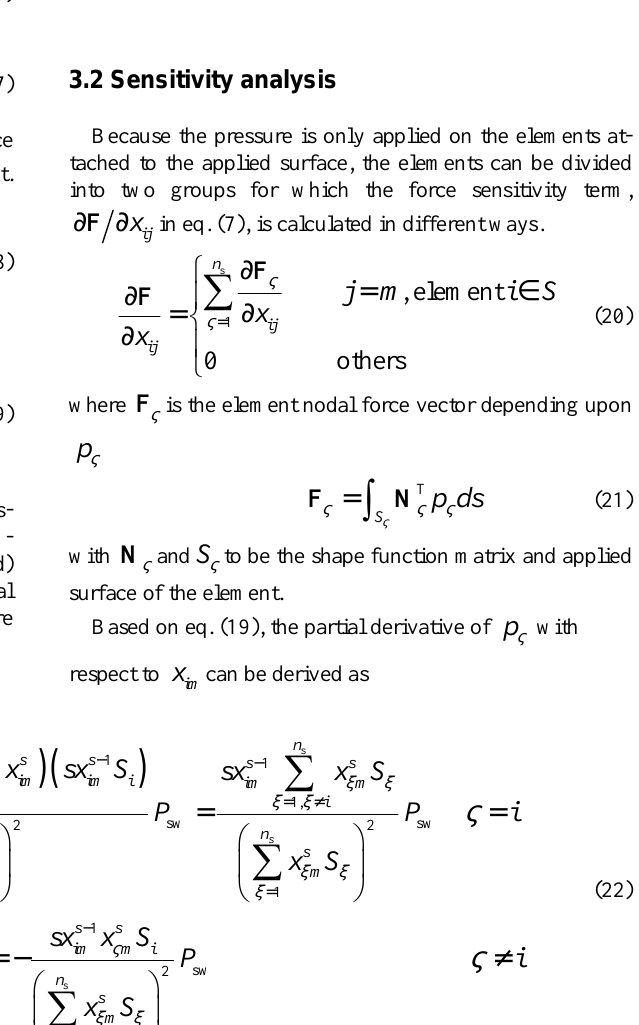
Fig. 4 Pressure load distribution using